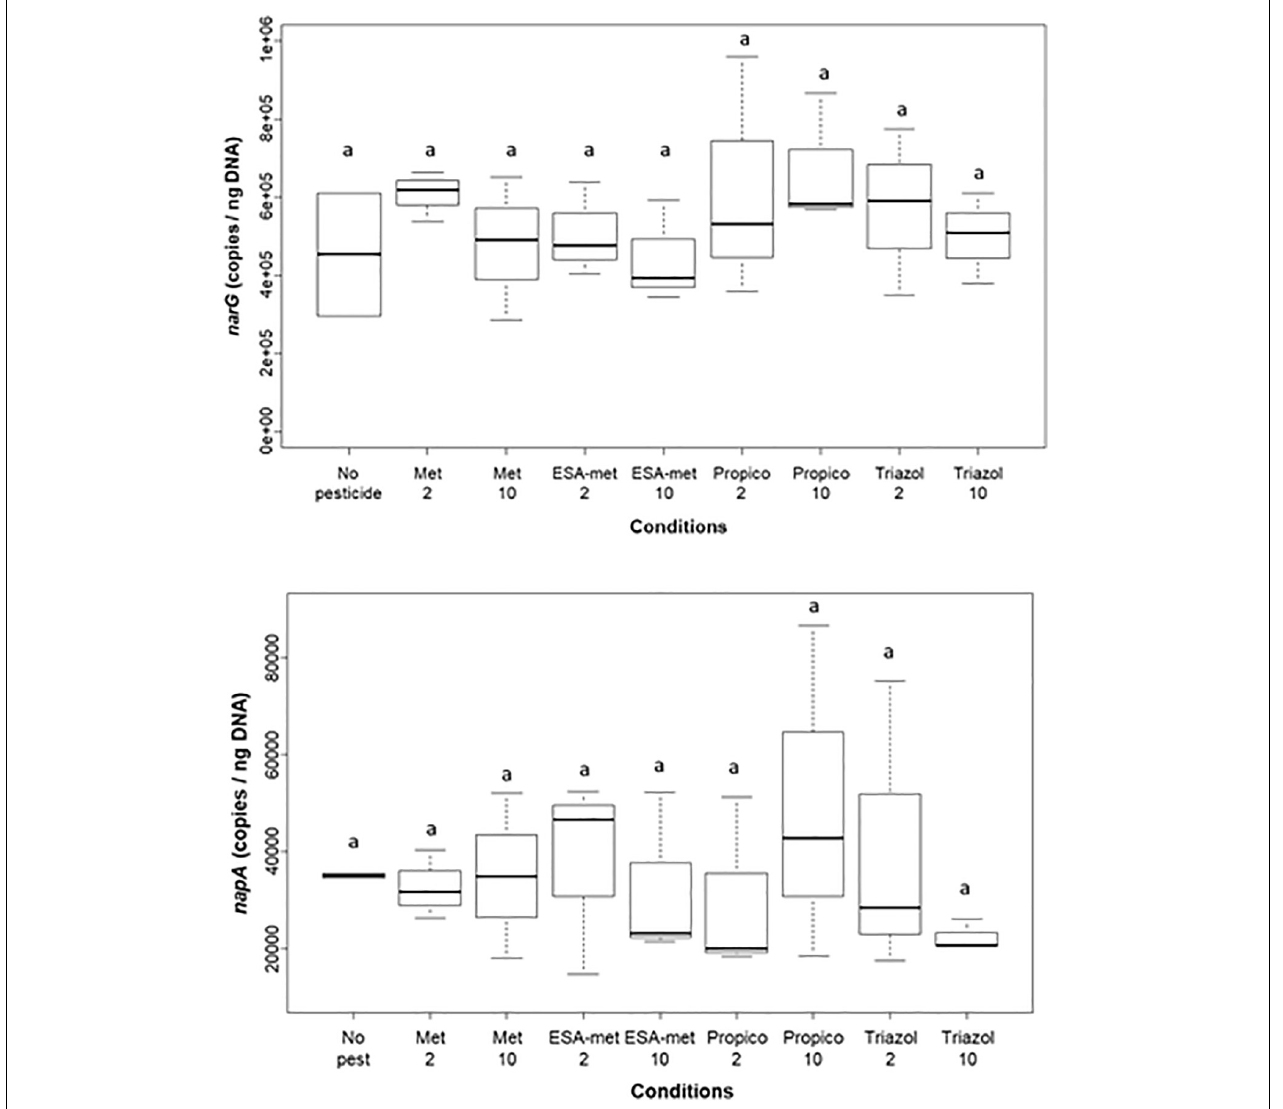
FIGURE 5 | Abundance of narG (top) and napA (bottom) genes (involved in nitrate reduction) at the end of batch experiments. Results are given as relative abundance, i.e., data were normalized by taking into account molecular biomass. No pest: no pesticide or metabolite (control); Met: metolachlor; ESA-met: ESA-metolachlor; Propico: propiconazole; Triazol: 1,2,4 triazole. 2 and 10 are pesticide or metabolite concentrations in µ g/L. Significant differences between conditions were searched applying the Kruskal–Wallis non-parametric test and are mentioned as a